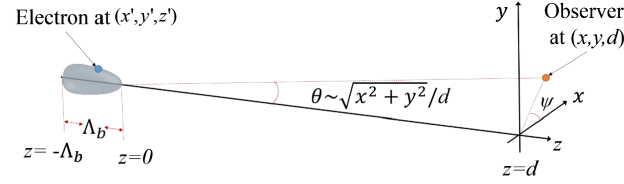
FIG. 3. Coordinates for calculating the bunching factor of an arbitrarily shaped electron beam with a length longitudinal Λ b located at a longitudinal distance d from an observer. θ is the observation angle or the emission angle with respect to the beam trajectory, and ψ is the azimuthal angle in the x - y